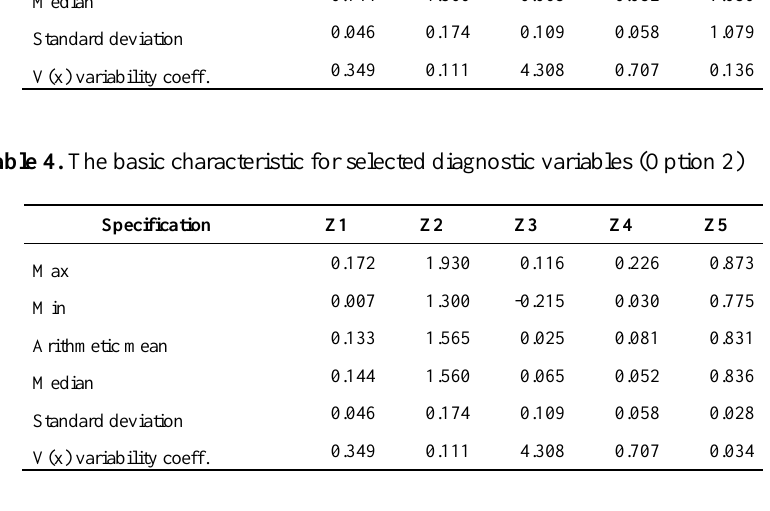
Table 5. Determinants of the duration of the “re-freezing” period of